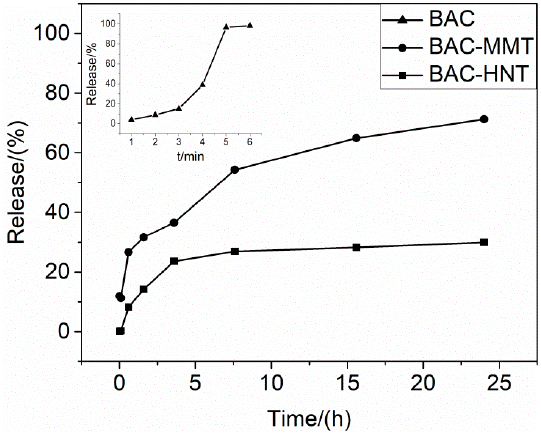
Table 2. Pore structure parameters of HNT and MMT from N2 adsorption–desorption isotherms.